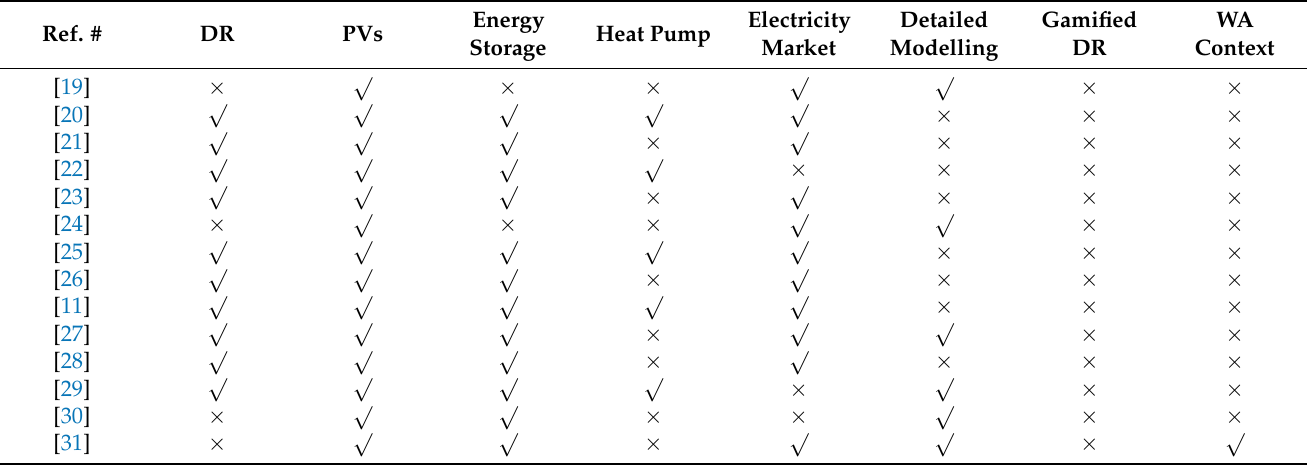
Table 1. A comparison of recent papers on VPP case studies. ( #: reference